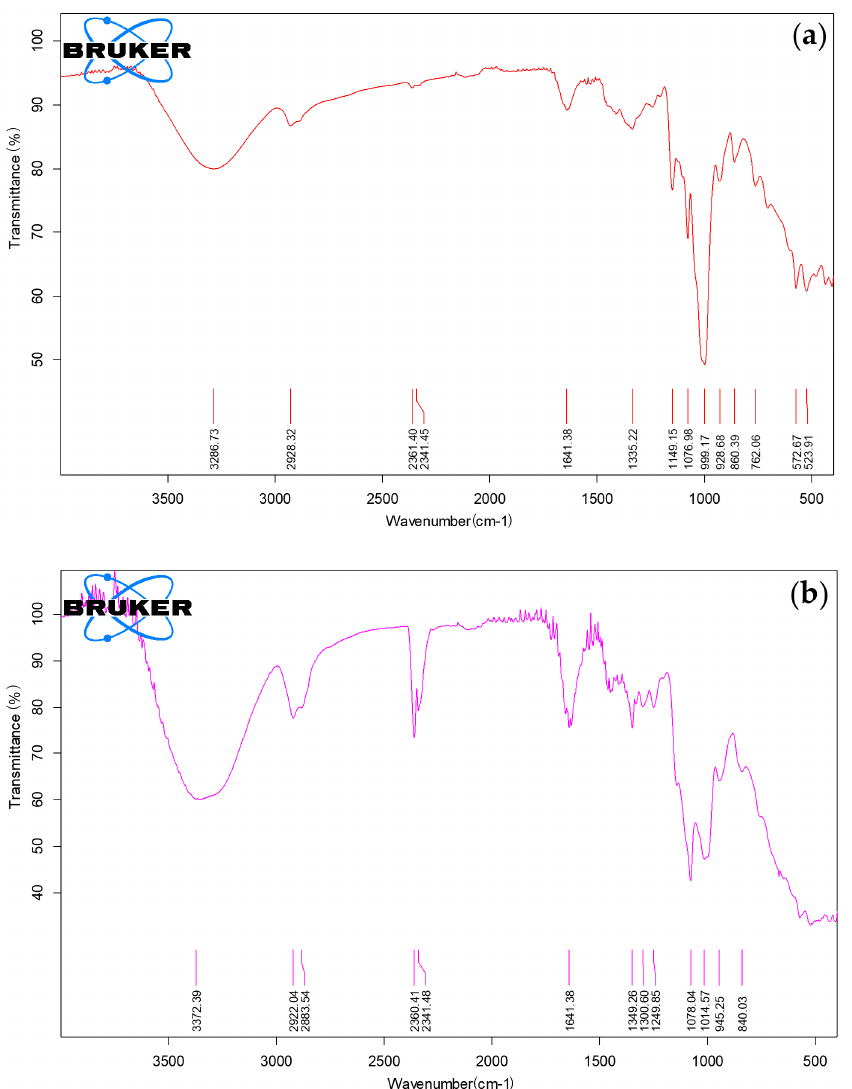
Figure 2. Illustrates the application of the Fourier transform infrared spectrophotometer (FT-IR) spectrum to, ( a ) the rice flour, ( b ) PEG-50 shea butter. They similarly provided an IR spectrum in the wavelength range of 1150–1085 cm − 1 , which is likely the aliphatic ether absorption range or